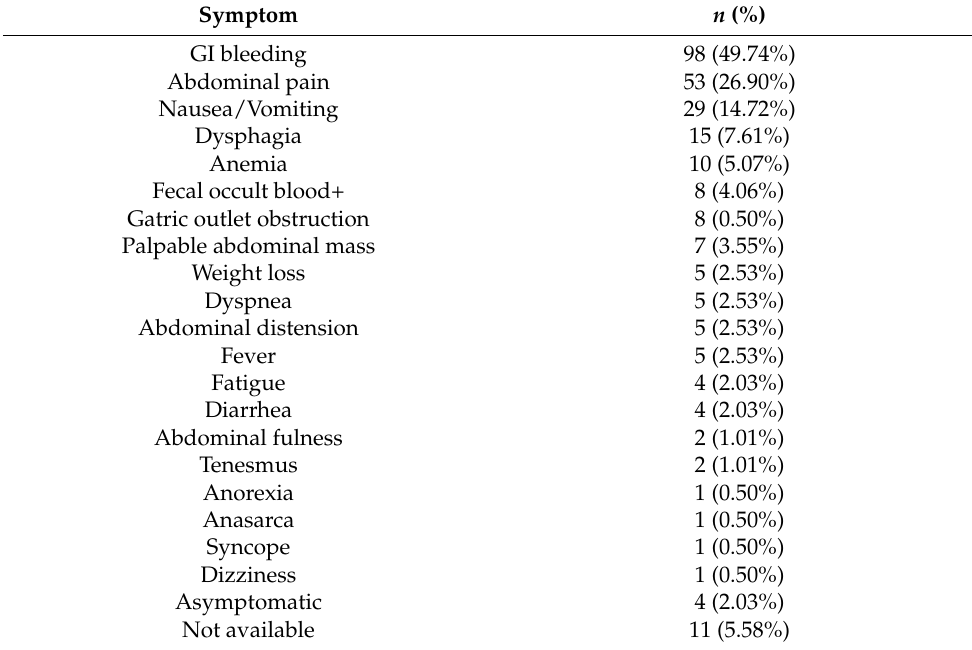
Table 7. Clinical features of included